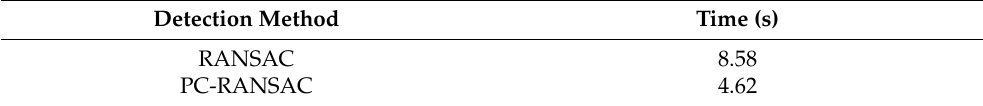
Figure 7. The average radius difference obtained by each algorithm in detecting the spherical surface. Table 4. Detection time of spherical surface for each algorithm.